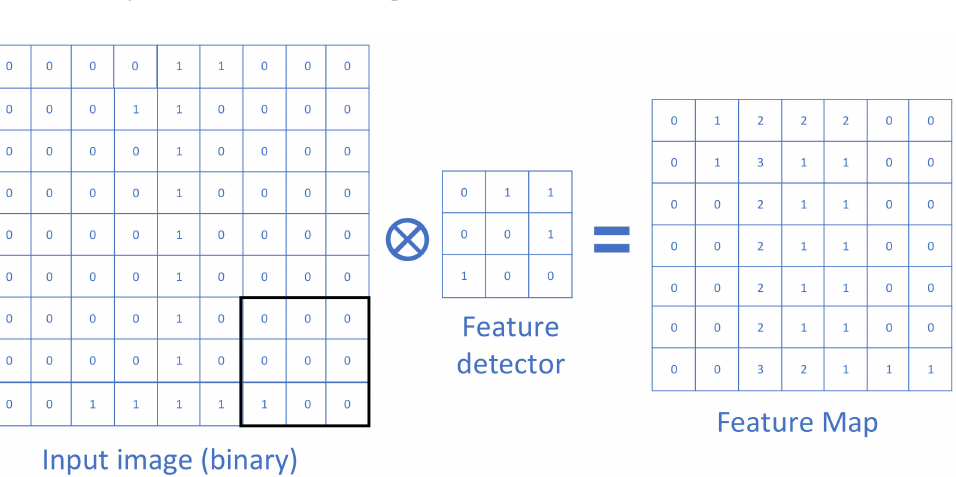
Figure 4. Binary conversion of feature map 4.